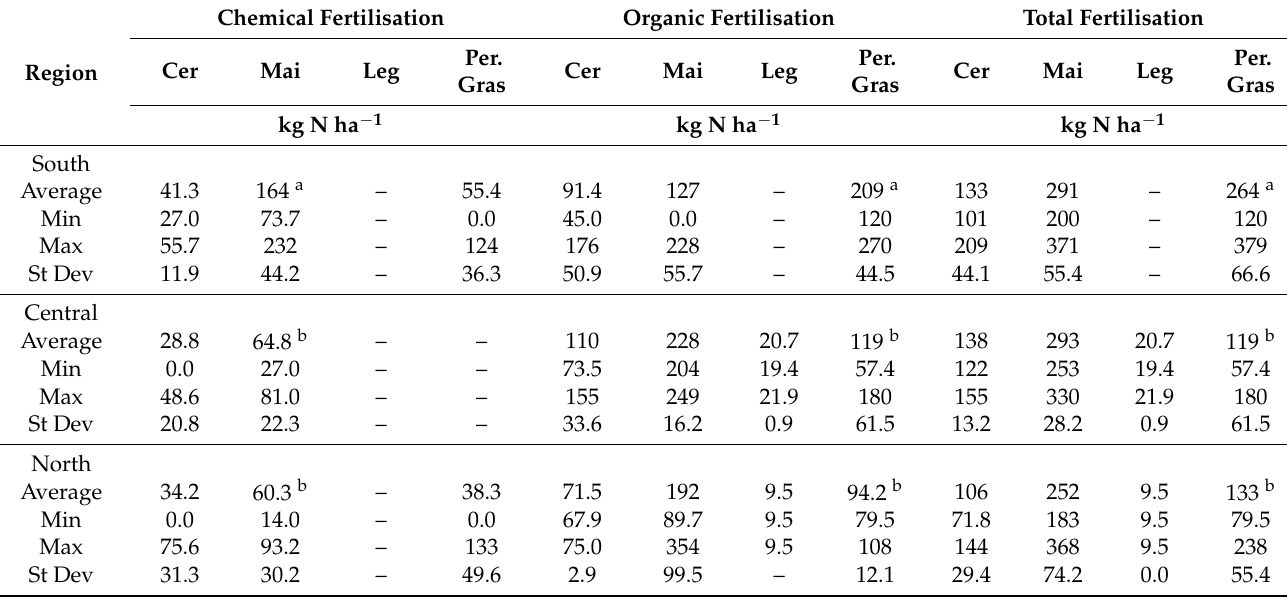
Figure 3. Amounts of organic and chemical fertilisers used on the 21 analysed dairy farms. The chemical fertilisers were nitrogen phosphorus (NP), calcium ammonium nitrate (CAN), and urea. Table 7. Analysed farm data: nitrogen fertilisation.